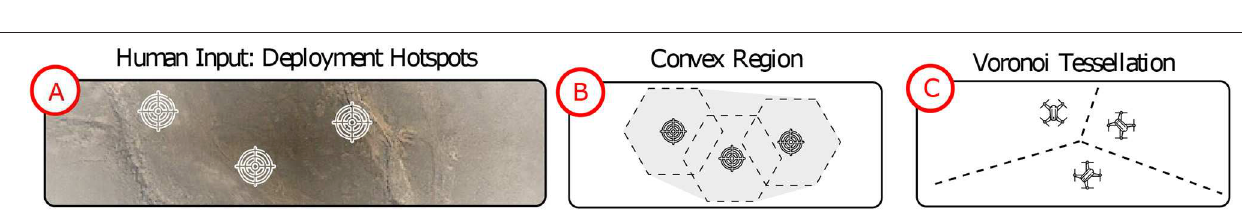
cover the whole region without it (larger cells). This